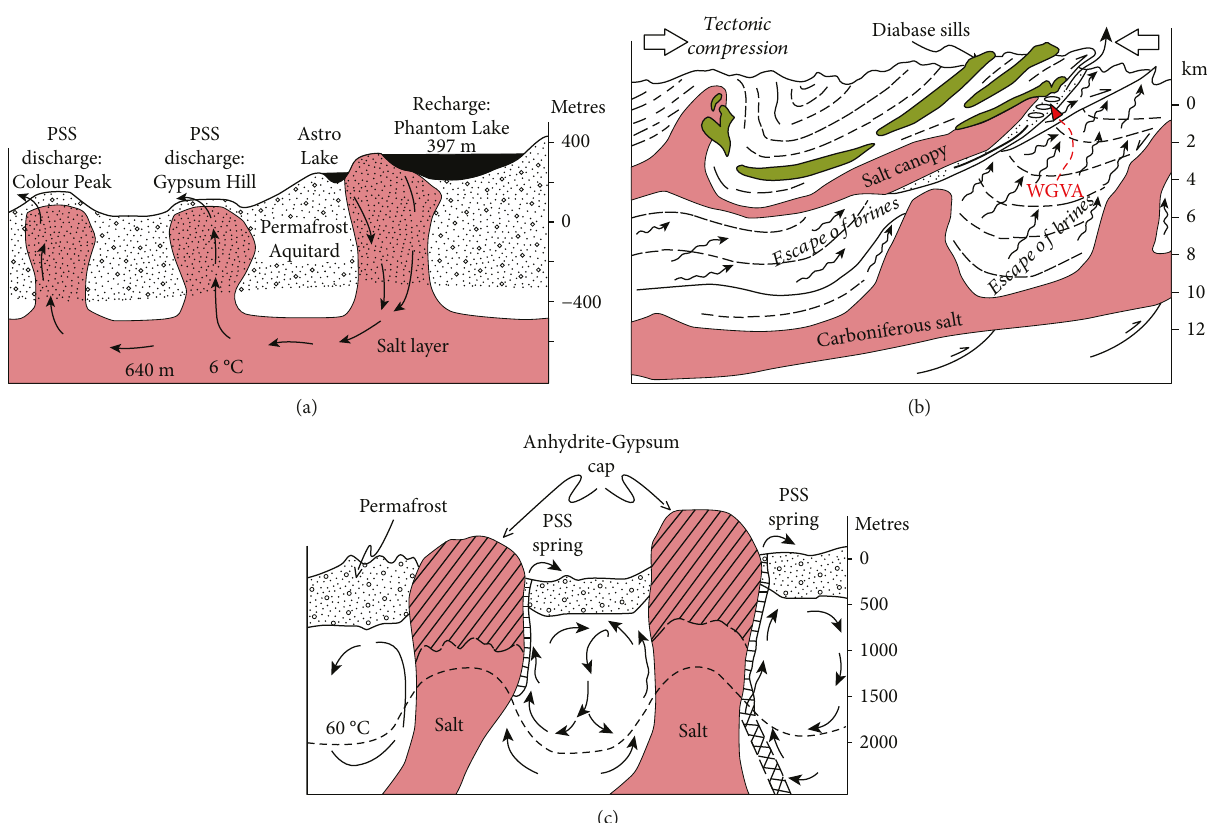
Figure 12: (a) Model for the perennial springs (PSS) as fi rst published by Andersen et al. [7] with fl uid recharge from glacial lakes through permeable evaporite (salt) diapirs, shallow circulation, and continuous escape. (b) Proposed model for White Glacier vein array (WGVA). Overpressured hot basinal fl uids expelled episodically through faults from under the salt canopy during tectonic compression of the Eurekan Orogeny (hypothetical subsurface structure modi fi ed from [6]). (c) Proposed hypothetical model for the perennial springs, where fl uids have a mixed origin and escape marginally to evaporite (salt-anhydrite-gypsum) diapirs through plumbing systems established during tectonic deformation (b). Not to scale. See text for discussion including description of